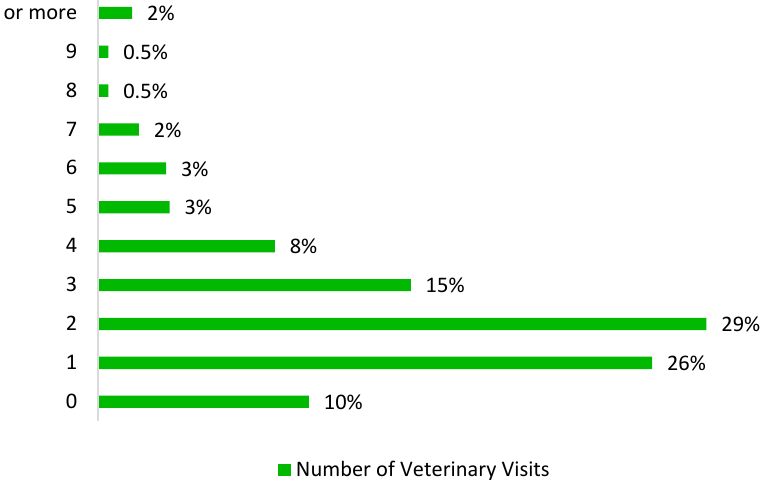
Figure 2. Total veterinary visits per pet owner per year.